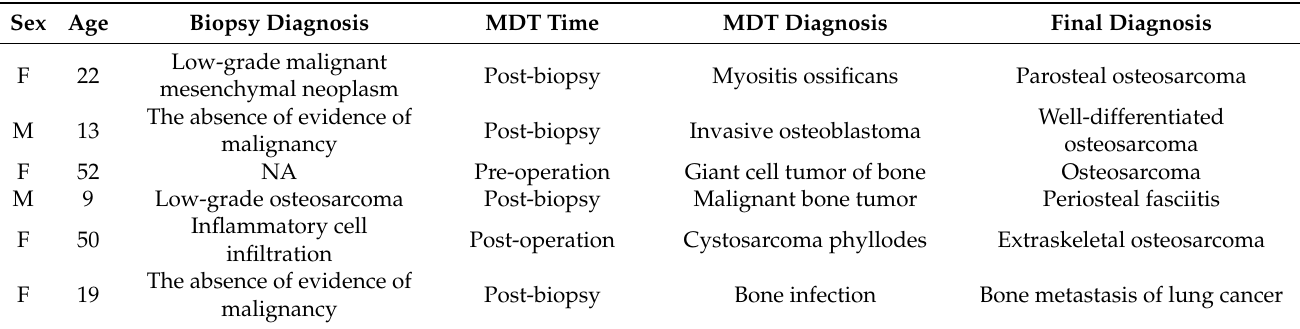
Table 2. The diagnosis corrected in six cases during MDT discussion after a biopsy. Table 3. Six misdiagnosed cases by the